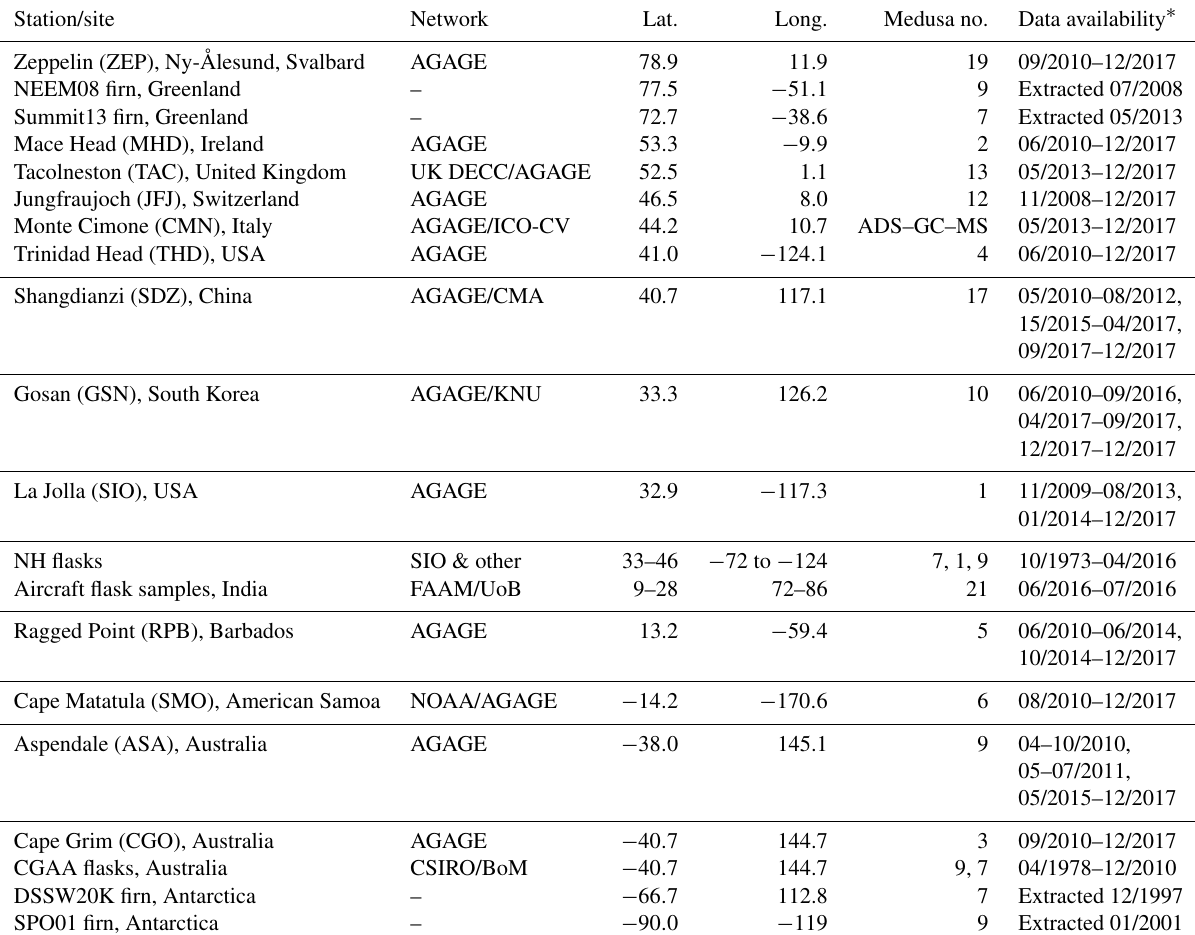
Table 1. Availability of c -C 4 F 8 in situ, flask, firn, and aircraft air measurements, measurements sites, and instrumentation.